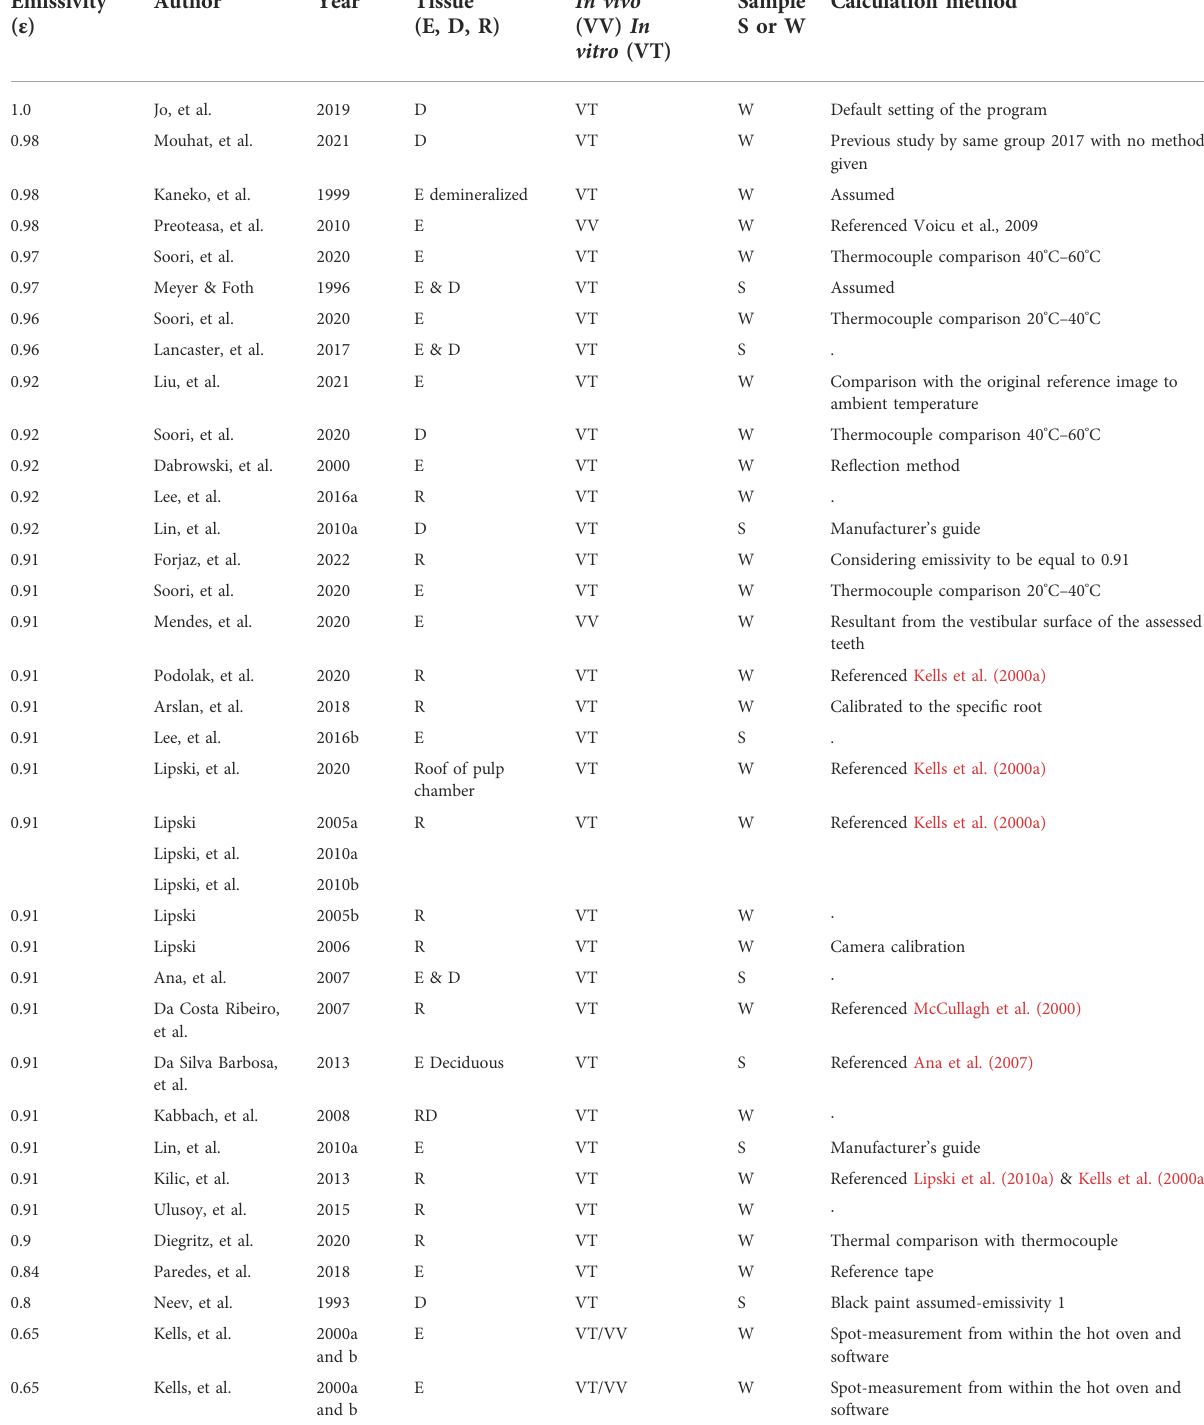
TABLE 1 Emissivity values sourced in literature to July 2022 for mineralized human tooth